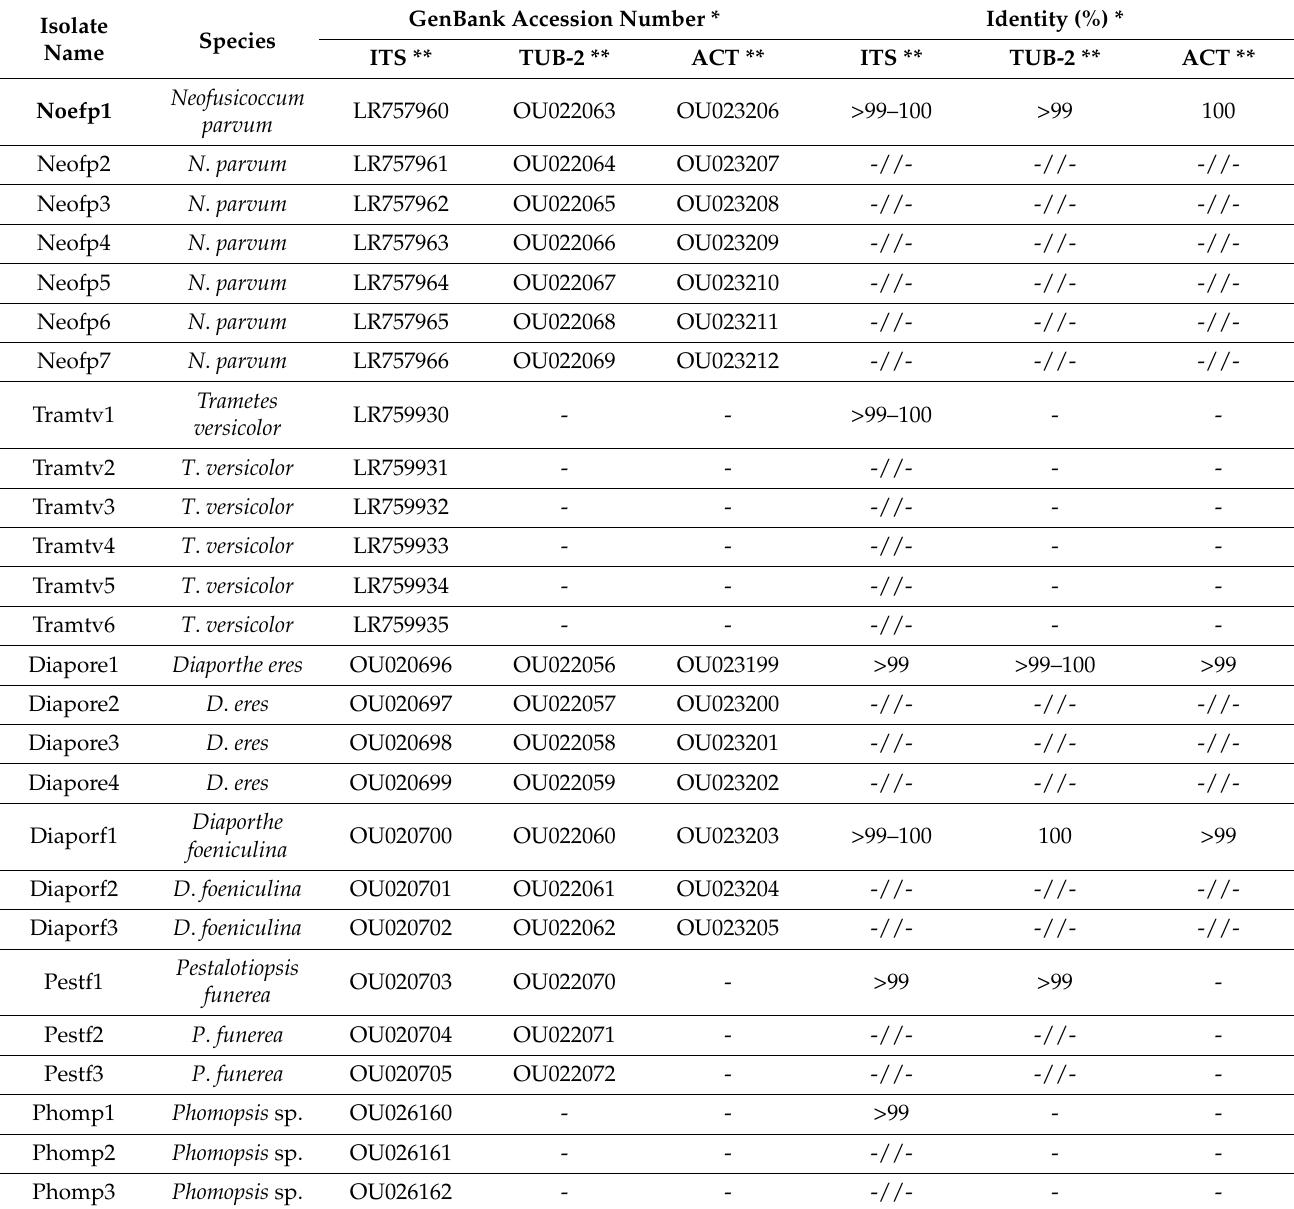
Table 1. Fungal isolates obtained during this study with their respective GenBank accession numbers and percentage of identity when compared to reference nucleotide sequences for the same species from the NCBI nucleotide